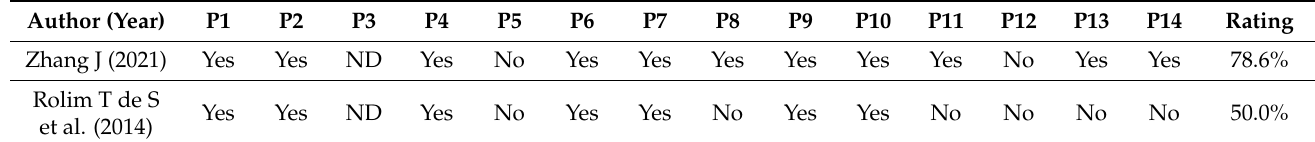
Table 3. Evaluation of the quality of the studies included (n =